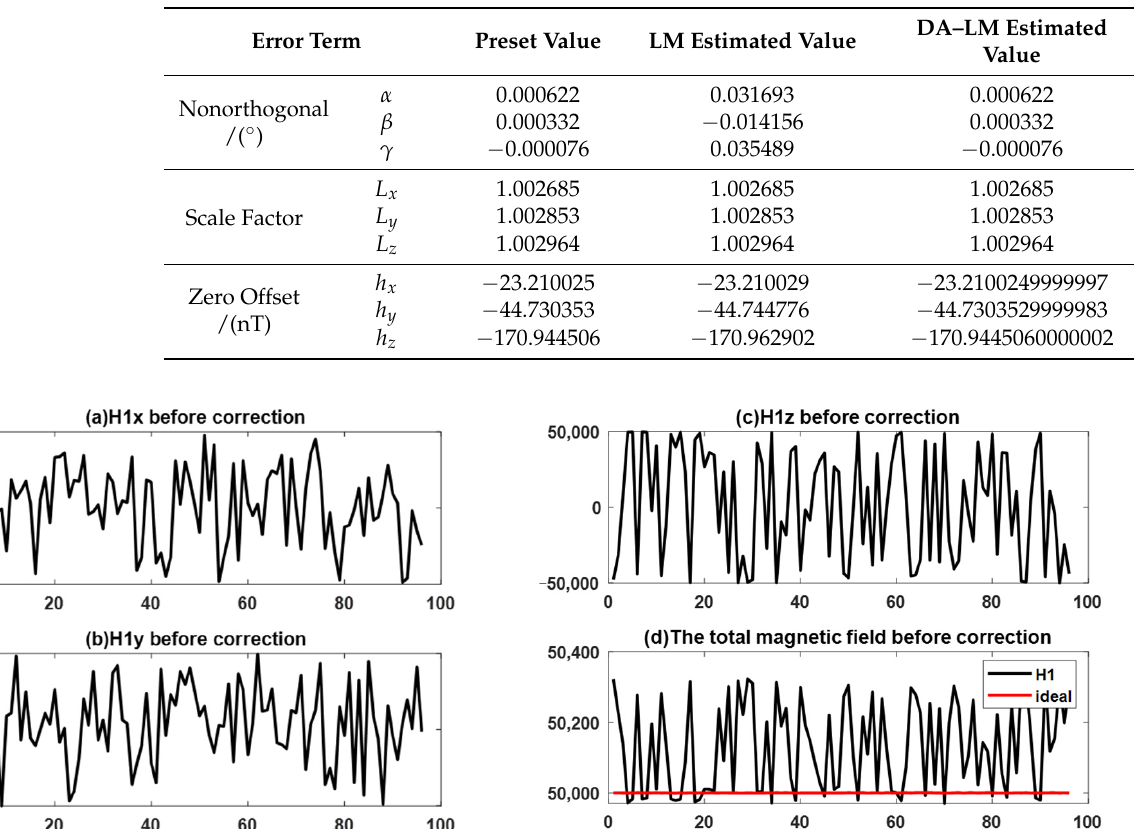
Table 1. Comparison of preset and estimate parameters.